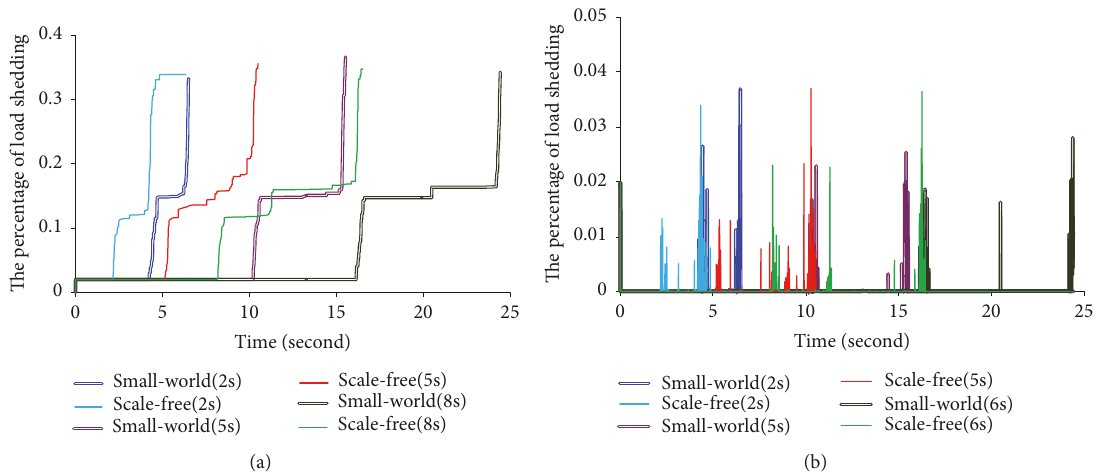
Figure 5: Load shedding of IEEE 118-bus system over time in the case of high-degree initial infectious vertexes. (a) Total load shedding over time; (b) real-time load shedding.